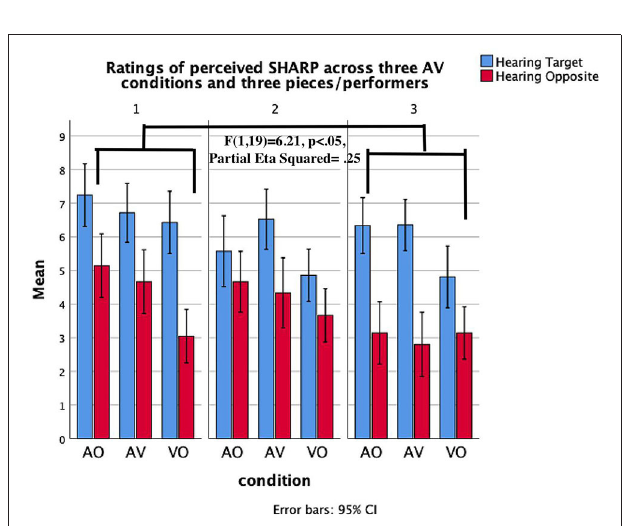
FIGURE 7 | Mean values of the evaluation of Sharp timbre across three pianists / pieces and AV stimuli. Error lines represent confidence intervals.